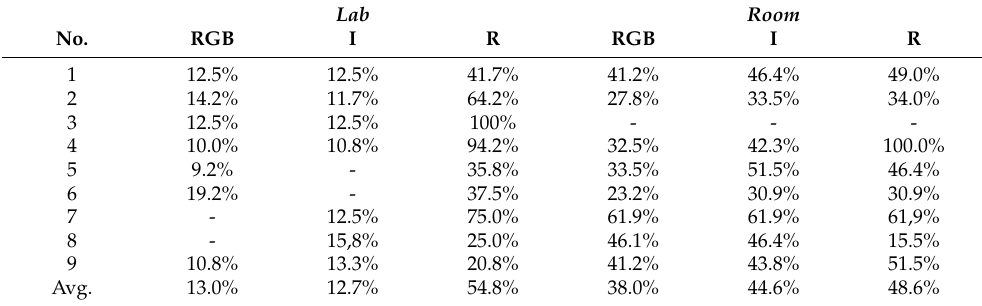
Table A2. Actual processing time in relation to the maximum processing time.